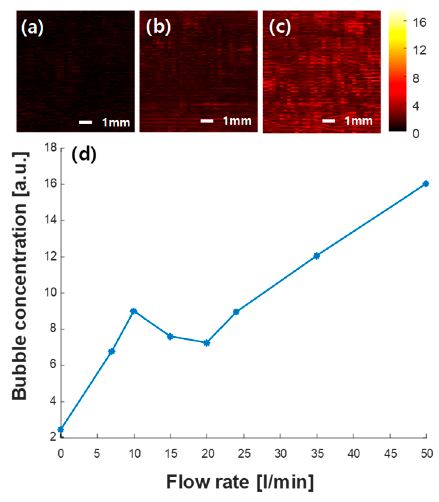
Figure 8. 2D ultrasound images of the liquid flowing in the pipe (color bar represents the ultrasound signal strength) at flow rates of ( a ) no flow, ( b ) 25 L / min, ( c ) 50 L / min, and ( d ) the relative bubble concentrations at varying flow rates.